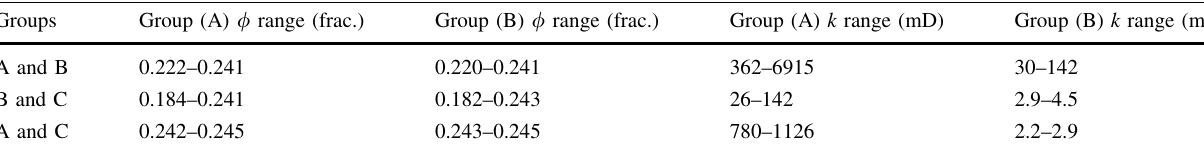
Table 3 Common porosity ranges between different groups versus equivalent permeability ranges Groups Group (A) / range (frac.)